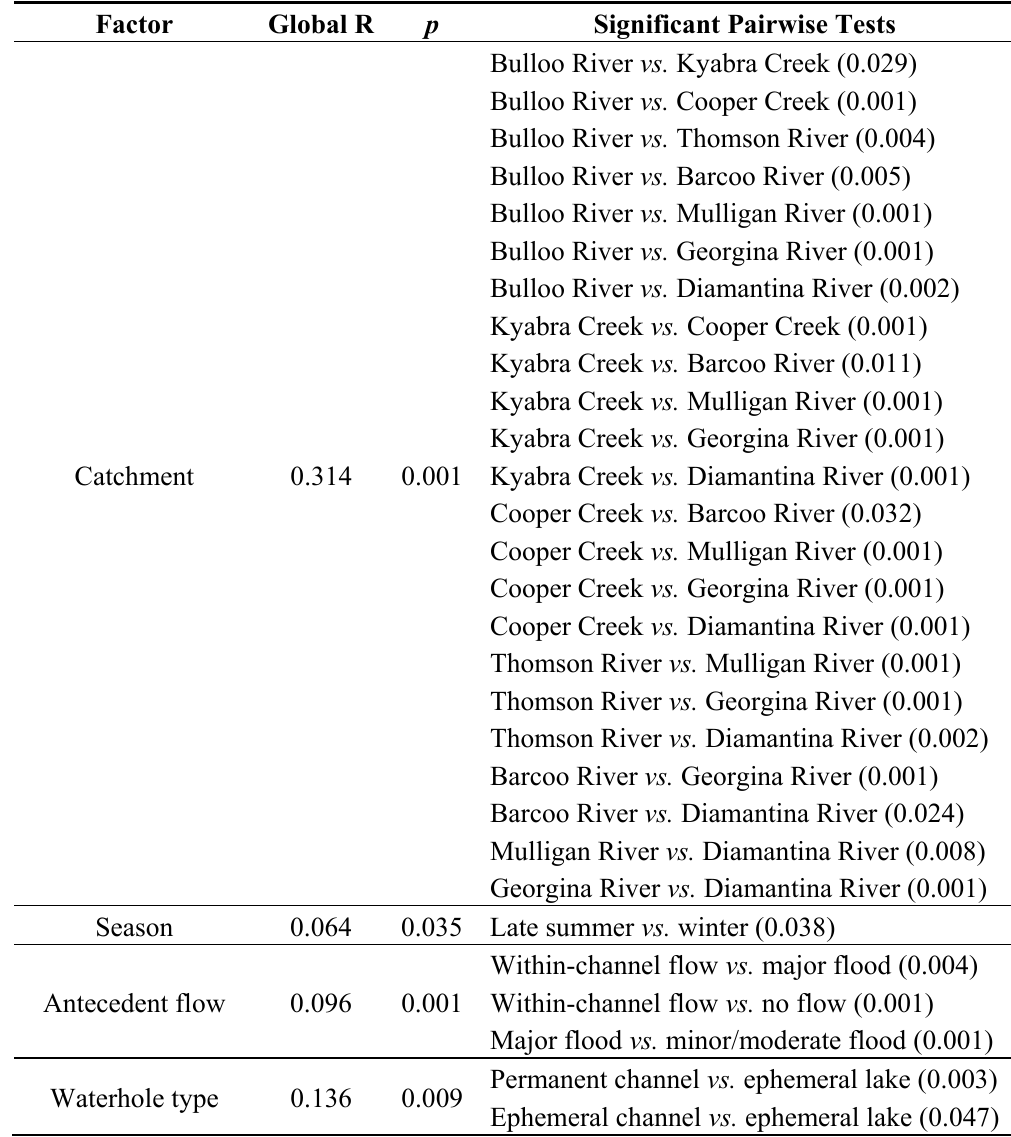
Table 2. Summary of One-Way ANOSIM results comparing fish presence/absence throughout the Lake Eyre Basin from April 2007–March/April 2008. All transformations